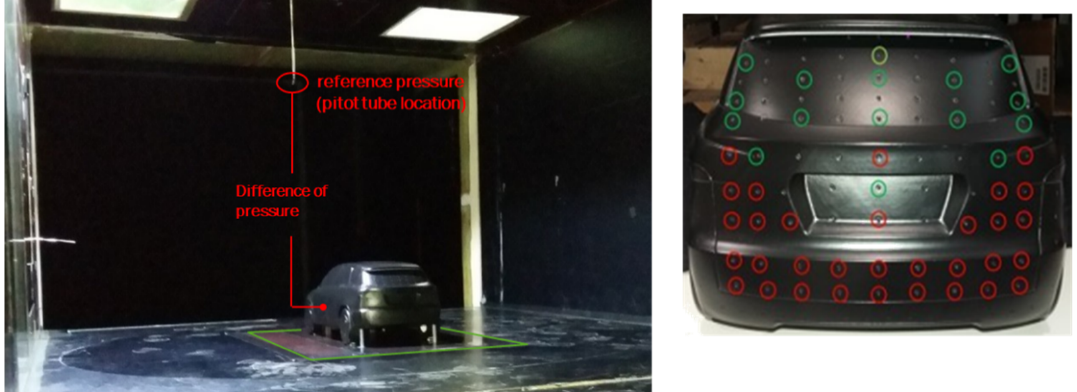
Figure 2. Mockup mounted in the wind tunnel, with the Pitot tube location. Tailgate and rear bumpers are equipped with instantaneous pressure sensors.